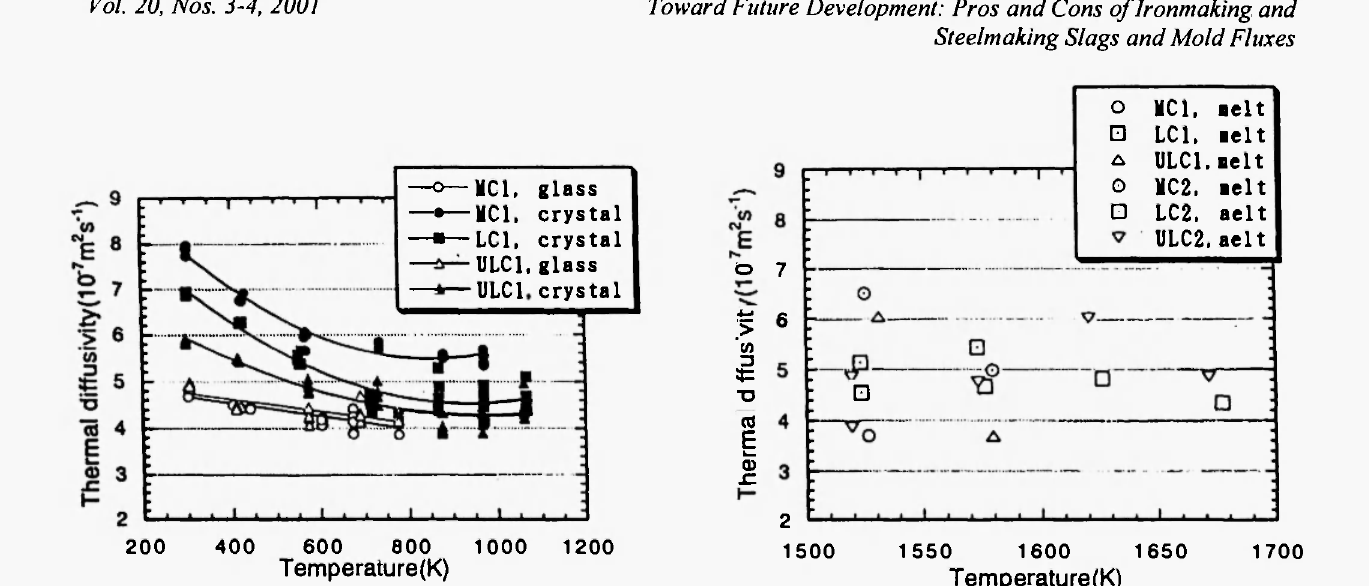
Thermal diffusivity of liquid (right figure)- and solid (left figure)-mold tluxes in commercial use (note that glassy fluxes show lower diffusivities than crystalline ones, but both come close at elevated temperatures. Also, extrapolation of the diffusivities from solid to liquid temperatures exhibits reasonable agreement with liquid diffusivities). Details of composition and other characteristics of fluxes for ultra-low carbon (ULC), low carbon (LC) and medium carbon (MC) steels are given in ref. 28.